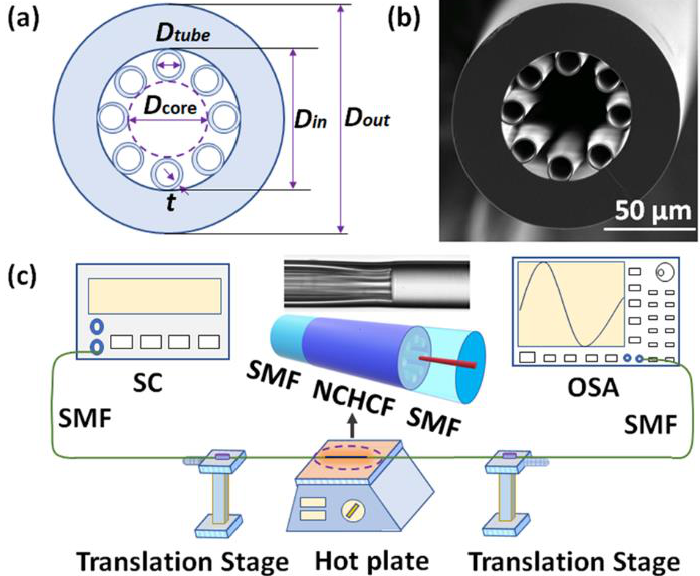
Figure 1. ( a ) Schematic diagram and ( b ) SEM image of the negative curvature hollow core fiber (NCHCF); ( c ) schematic diagram of the experimental setup for strain and temperature measurements. Inset microscope image shows the connecting point between singlemode fibers (SMF) and NCHCF after one arc splice.